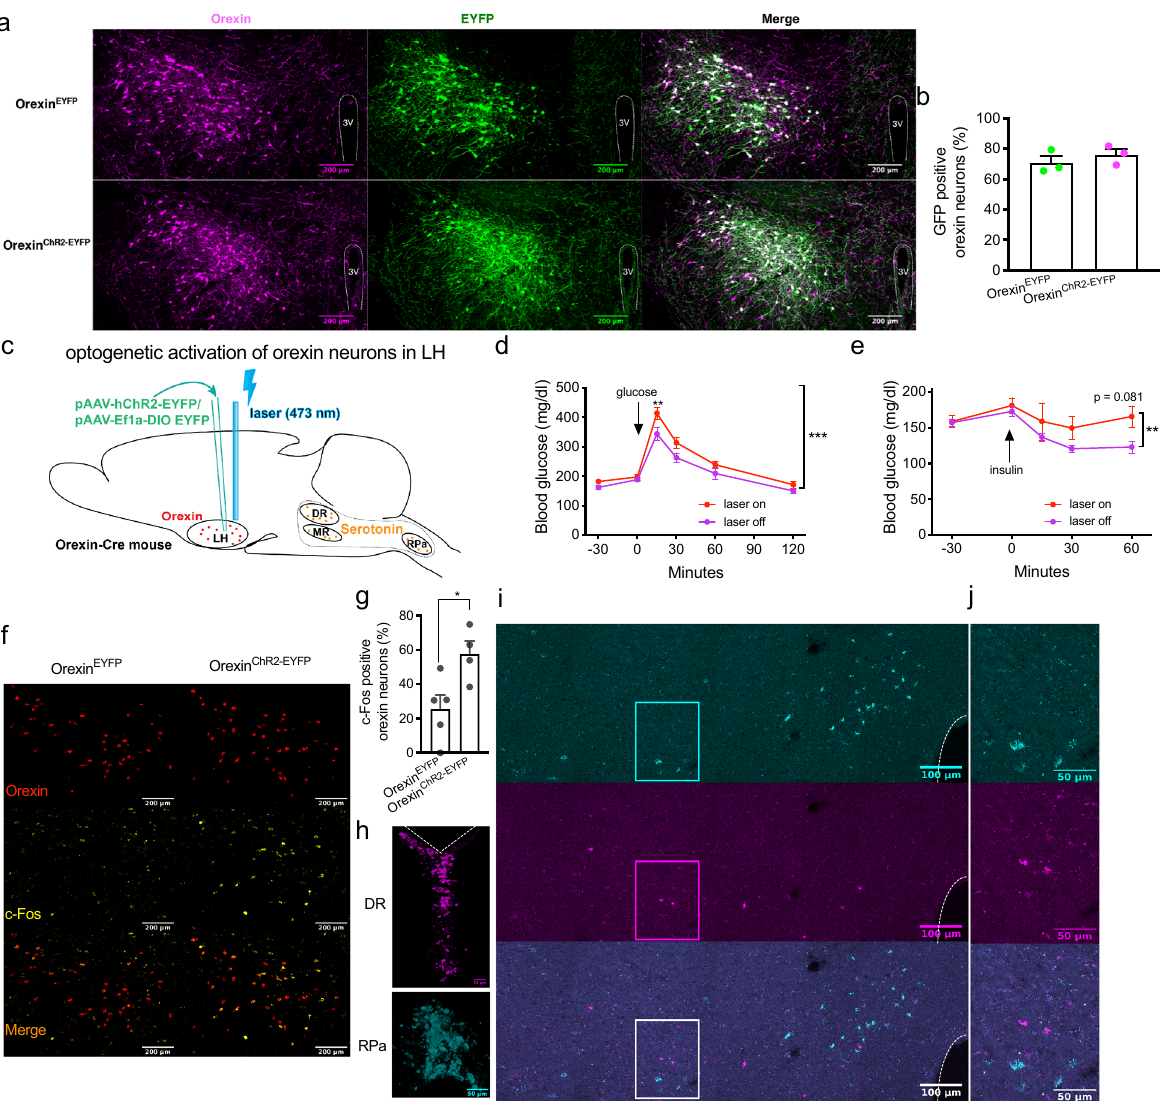
Fig. 8 Optogenetic stimulation of orexin neurons impairs glucose tolerance. a Representative images of immunostaining of orexin and EYFP in the lateral hypothalamus (LH) of Orexin-Cre mice injected with Cre-dependent adeno-associated virus pAAV-EYFP (Orexin EYFP ) or pAAV-ChR2-EYFP (Orexin ChR2-EYFP ). n = 3. b Quanti fi cation of percentages of GFP positive neurons in orexin neurons of mice injected with AAV. n = 3. Magenta, orexin; green, EYFP. c Schematic drawing of the strategy of optogenetic stimulating of orexin neurons. d Glucose tolerance test and e insulin tolerance test of Orexin ChR2-EYFP mice with (laser on) or without (laser off) laser illumination in LH. d n = 10, p = 0.0056 (15min); e n = 9, p = 0.081 (60min). f Representative images of RNAscope in situ hybridizations of c-Fos and orexin in LH and g the quanti fi cation of percentages of c-Fos positive neurons in orexin neurons after laser illumination. n = 5 or 4. p = 0.027. Red, orexin; yellow, c-Fos. h Representative images of retrobeads injected in dorsal raphe nucleus (red beads) and raphe pallidus (green beads). i Representative images of retrobeads traveled to LH, in which the squares-indicated regions were ampli fi ed in ( j ). n = 5. Magenta, red beads; cyan, green beads. Scale bar: 200 µ m ( a , f ), 100 µ m ( i ) or 50 µ m ( h , j ). Data are represented as means±SEM. * p <0.05, ** p <0.01, *** p <0.001; as determined by unpaired two-tailed Student ’ s t -test ( g ) or two-way ANOVA followed by Sidak ’ s post hoc test ( d , e ). Two-way ANOVA revealed a signi fi cant main effect of genotype in ( d ) ( F (1, 108) = 15.75, p = 0.0001), and ( e ) ( F (1, 80) = 7.00, p = 0.0098). Source data are provided as a Source Data fi